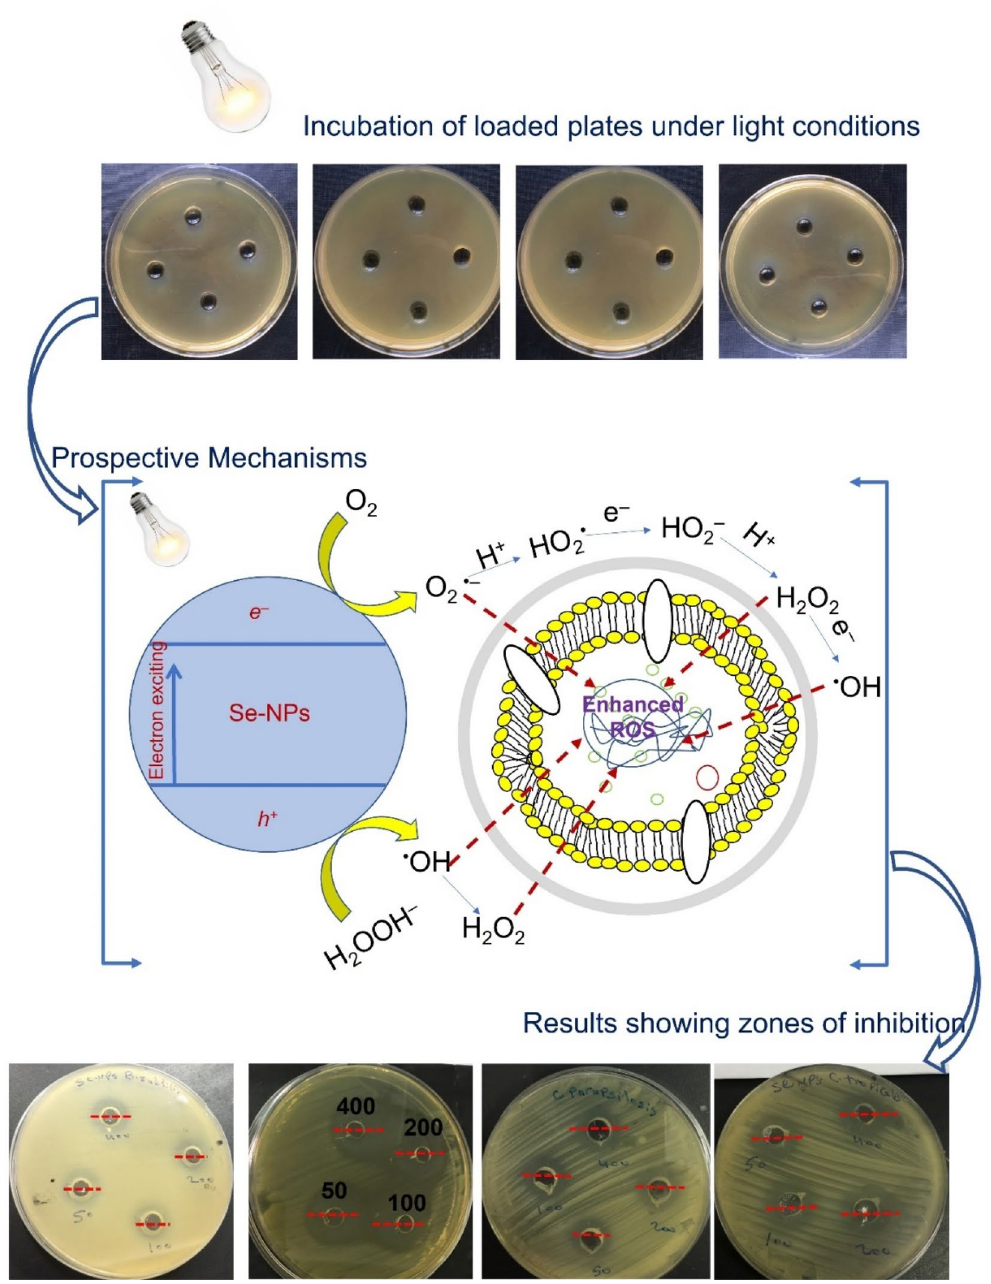
Figure 5. The prospective antimicrobial mechanism of Se-NPs upon exposure to